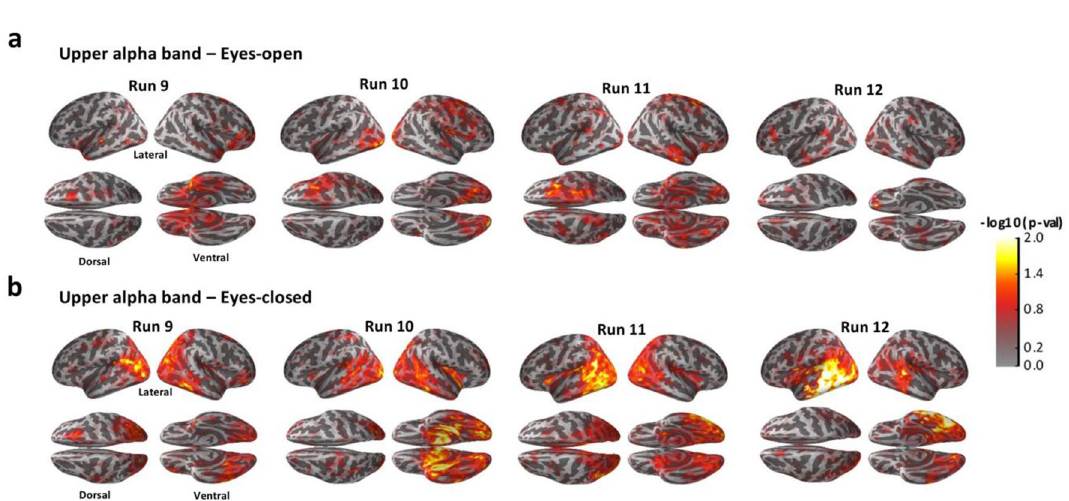
Figure 4. p value maps of one-way ANOVA on MEG baseline-corrected upper alpha band power spectral density of RF-EMF post-exposure sessions (real vs. sham) at source level analysis during eyes-open recordings ( a ) and eyes-closed recordings ( b ). p values were computed for each MEG source location (4098 current dipoles per hemisphere) for 29 subjects ( p < 0.05). The cortex is shown inflated with gyri darker than sulci, with lateral (left and right), dorsal and ventral